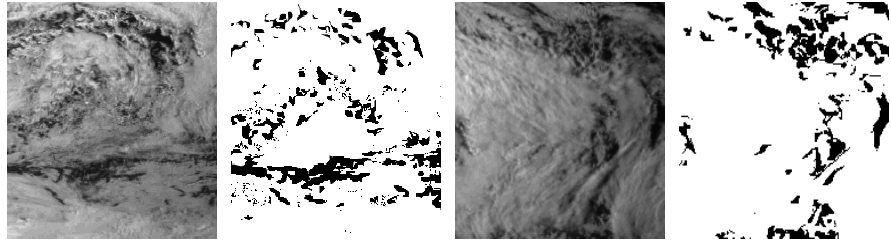
Figure 15. The first and third columns are the VIS images, and the second and fourth columns are the ground truth results.